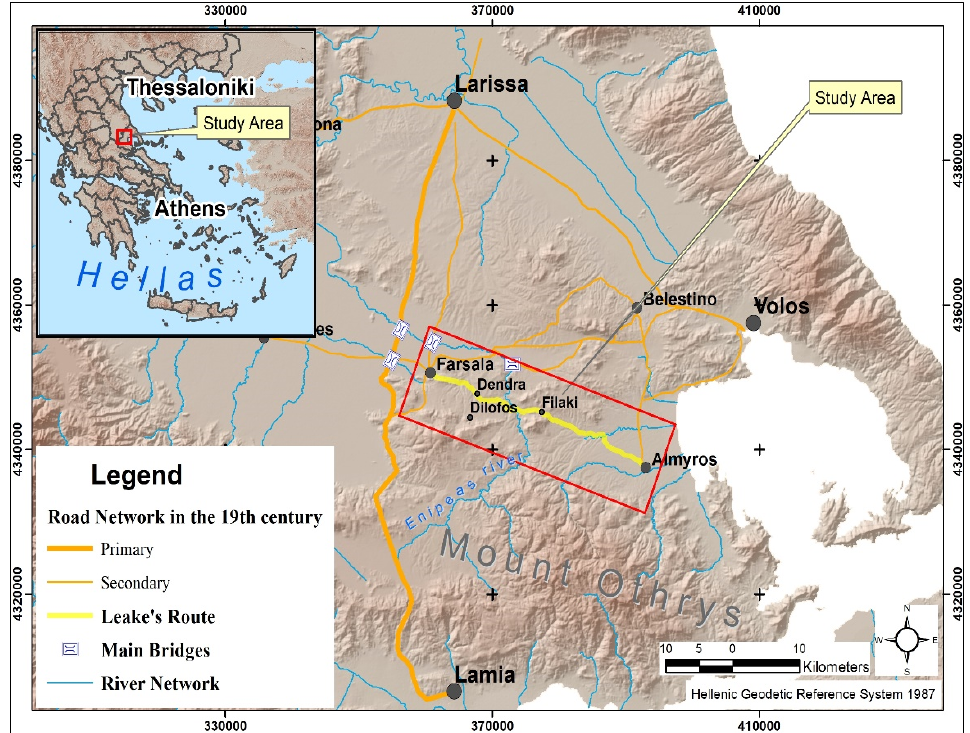
Figure 1. The area travelled by Leake in the 19th century.